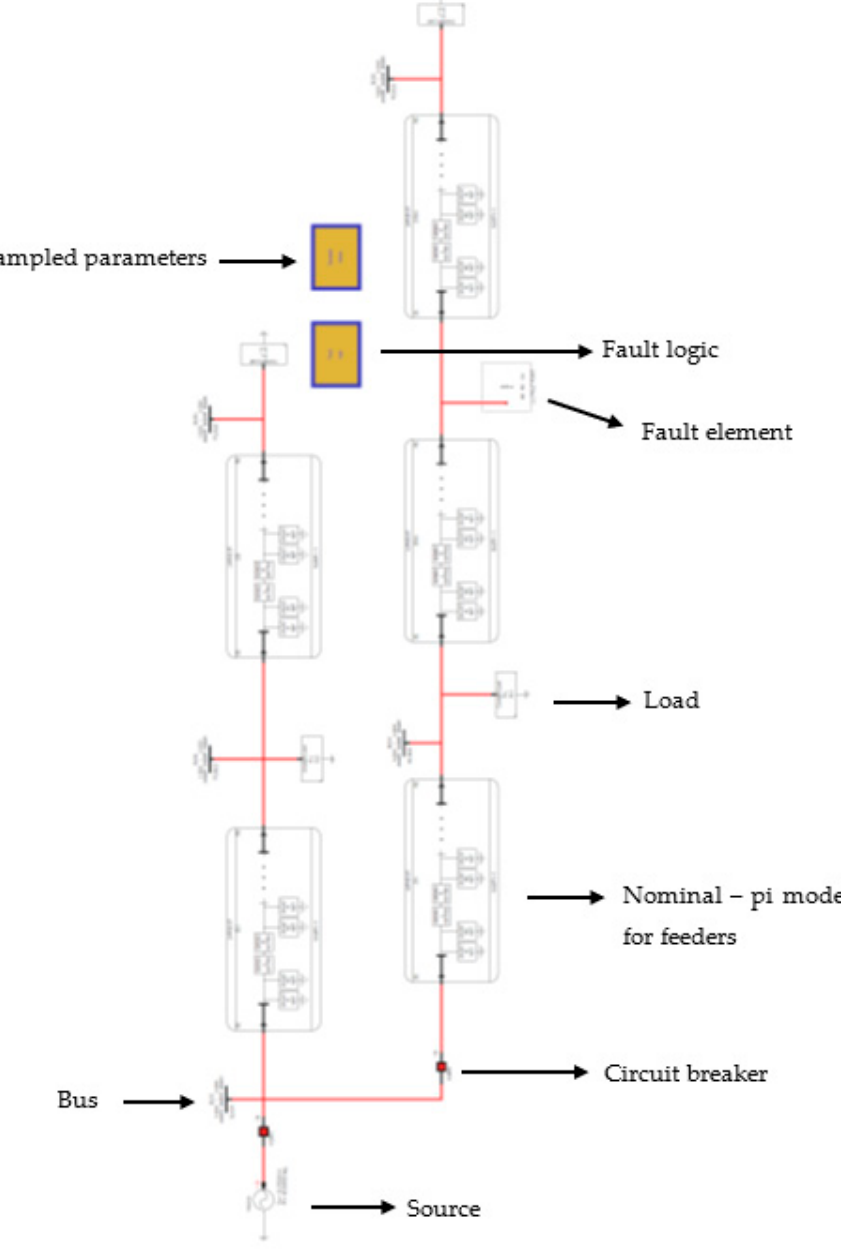
Figure 2. Module 1 of the RSCAD model.